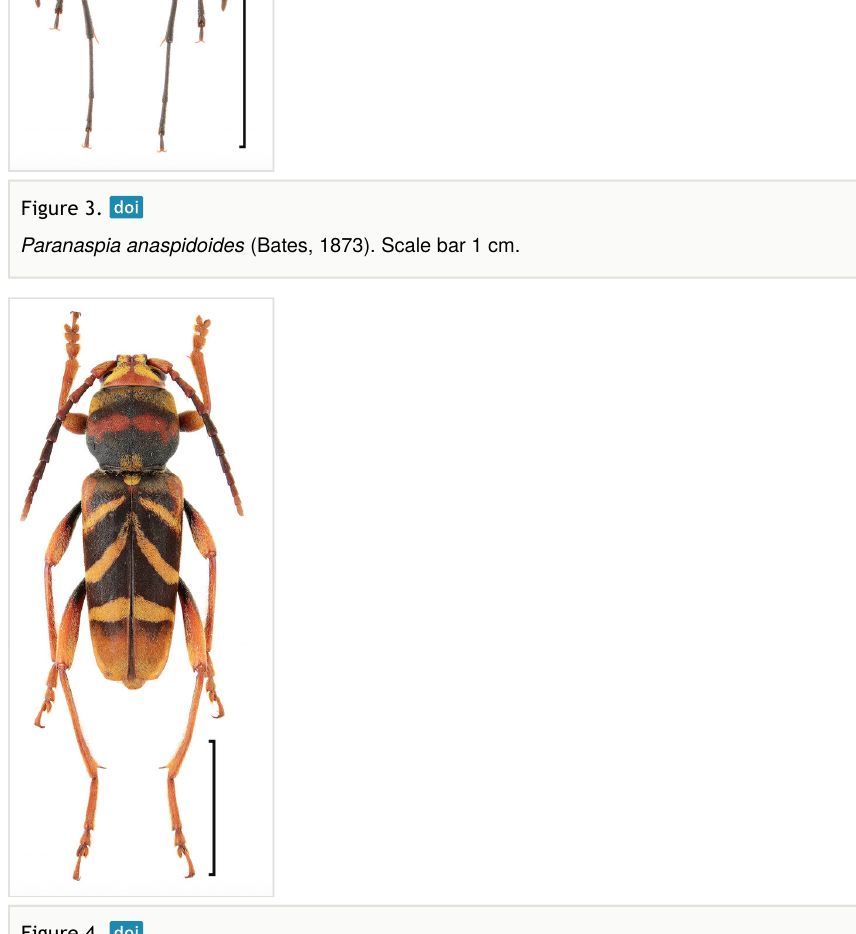
Figure 4. Xylotrechus ( Xyloclytus ) chinensis kurosawai Fujita, 2010. Scale bar 1